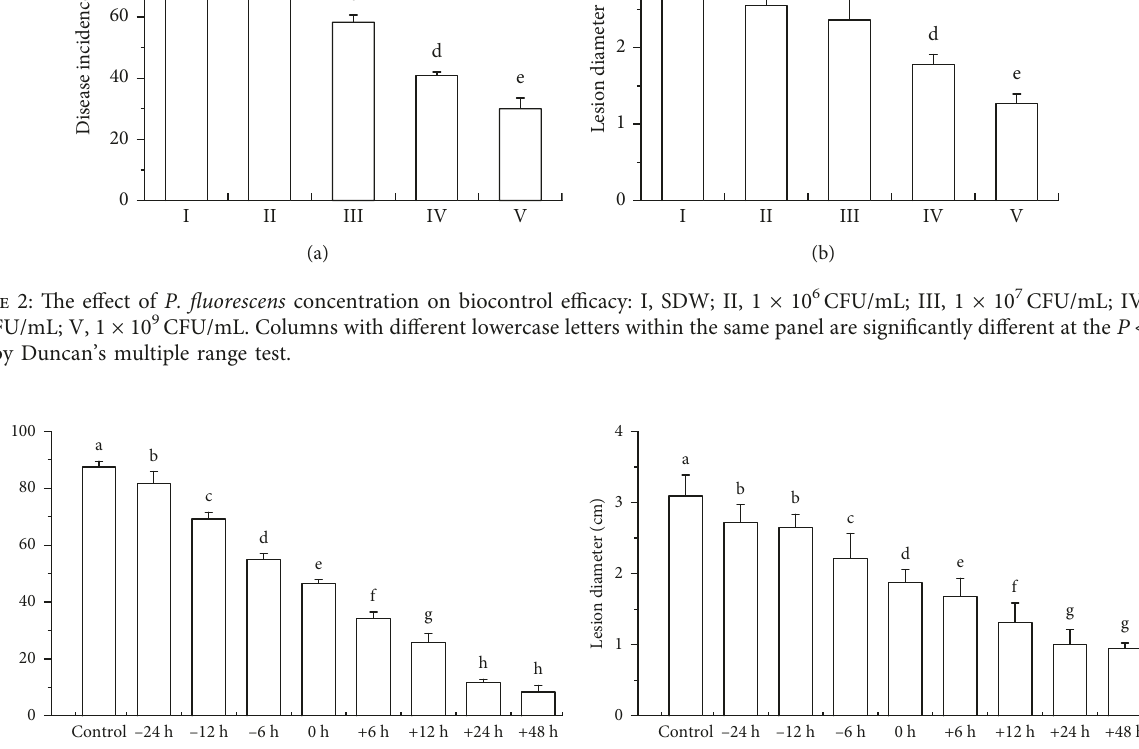
Figure 3: Preventative action and curative action of P. fluorescens against to P. digitatum. fluorescens ; +, citrus were inoculated P. fluorescens prior to P. digitatum . Columns with different lowercase letters within the same panel are significantly different at the P 0 . 05 level by Duncan’s multiple range test. <